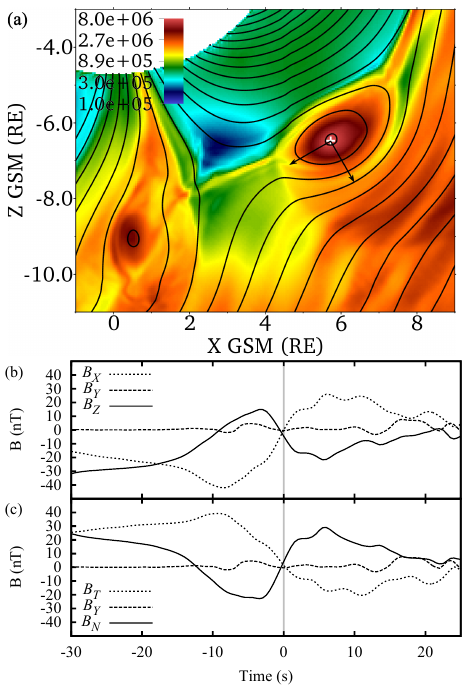
Figure 2. (a) Close-up view of the large magnetic island from Fig. 1 travelling tailward along the magnetopause. Colour code: plasma number density, protons m − 3 . Contour lines: magnetic field lines. Arrows: rotated coordinate system (N,Y,T ) with N normal to the magnetopause and T parallel to it. (b) Magnetic field evolution at a virtual spacecraft located at the white cross in panel (a) , in sim- ulation (GSM) and (c) rotated coordinates. The grey vertical bar indicates the time of panel (a) and Fig. 1. The characteristic bipo- lar signature of the passing magnetic island is obvious in the B N